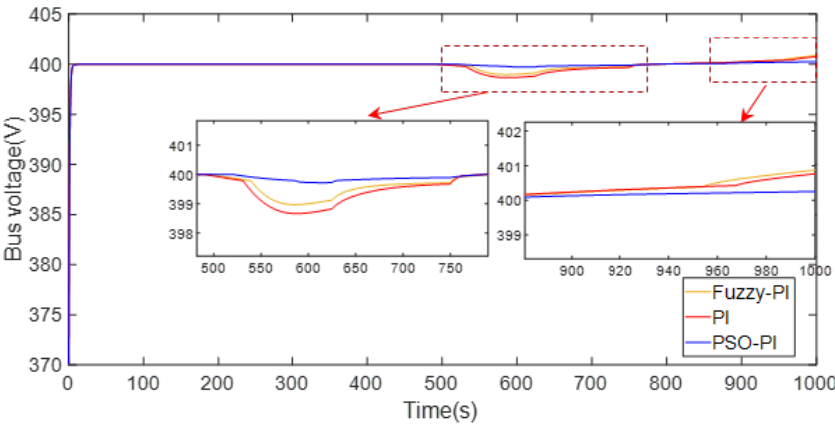
Figure 20. Fluctuation of light intensity in Example 2.